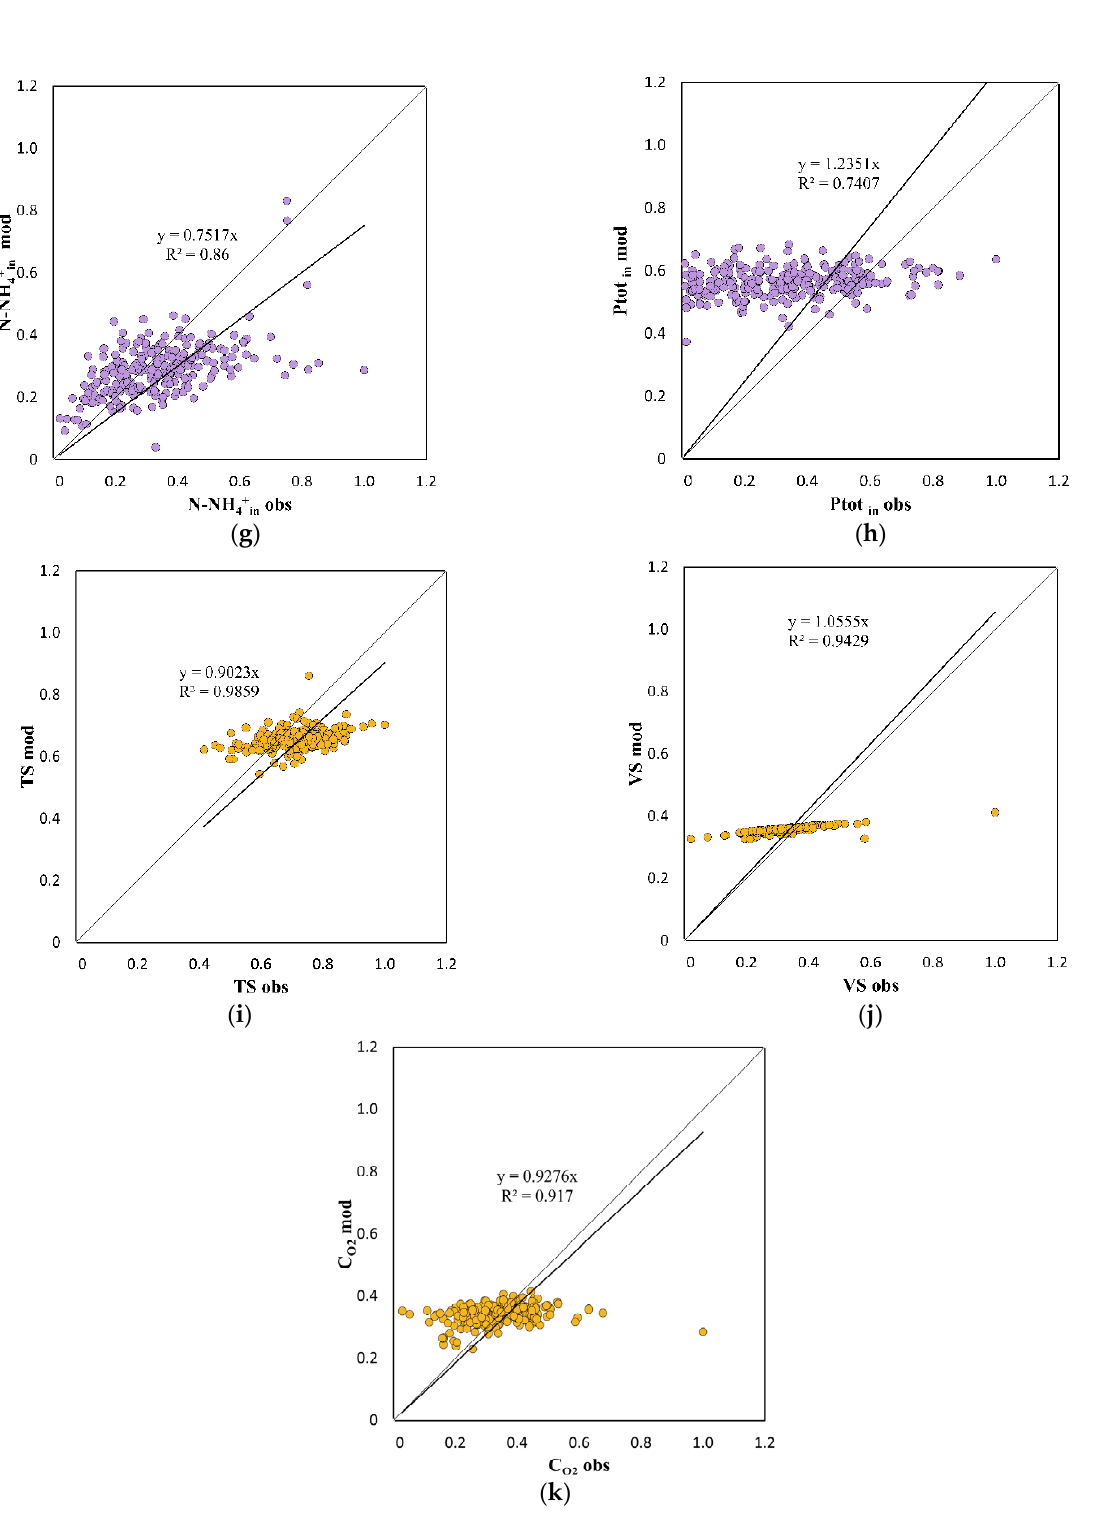
Figure 4. Multivariate linear regressions: comparison between normalized observed value and modelized values Figures from ( a – k ) show the trend of the measured values and of the modeled values considering both the concentrations of pollutants in input and their removal efficiency.